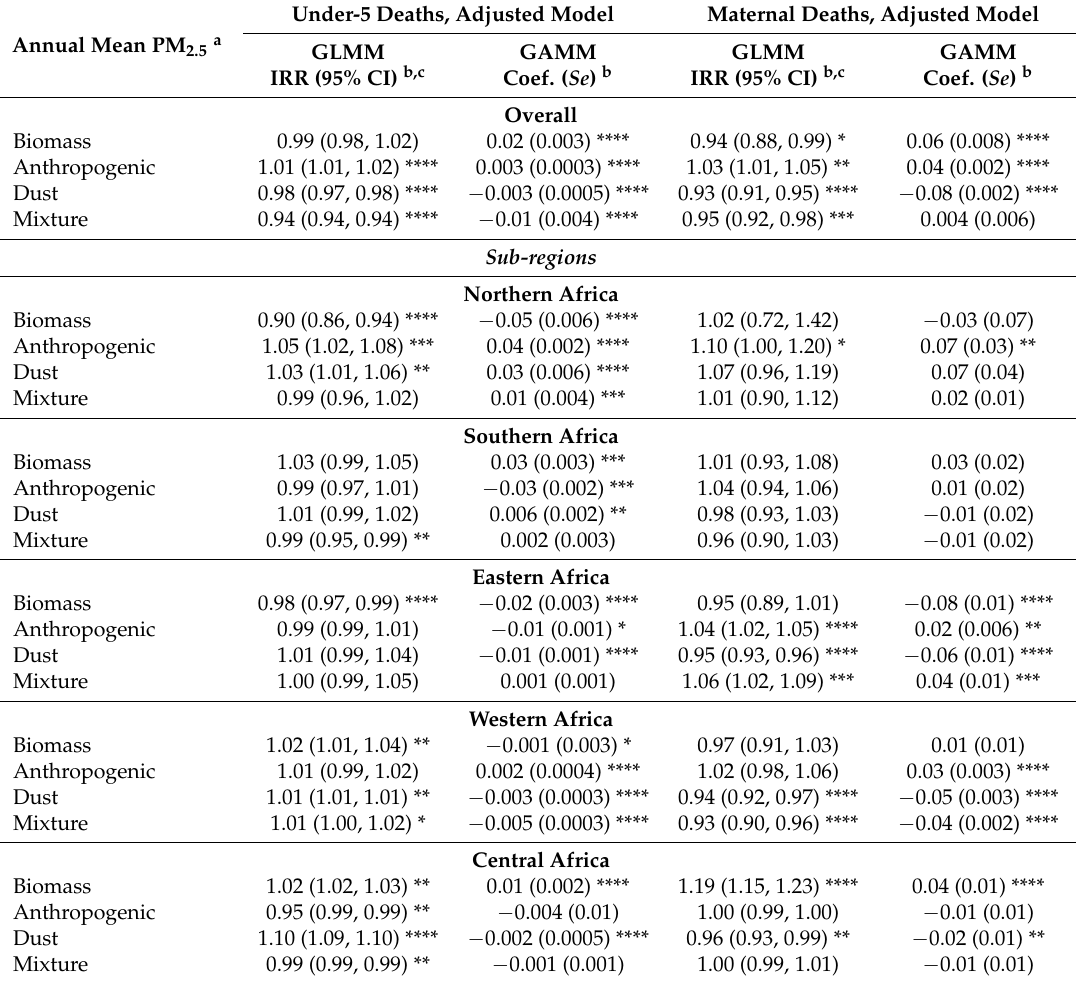
Table 3. Adjusted incidence rate ratio (IRR) and 95% confidence interval (CI) of the generalized linear mixed-effect model of under-5 and maternal mortality by sub-regions of